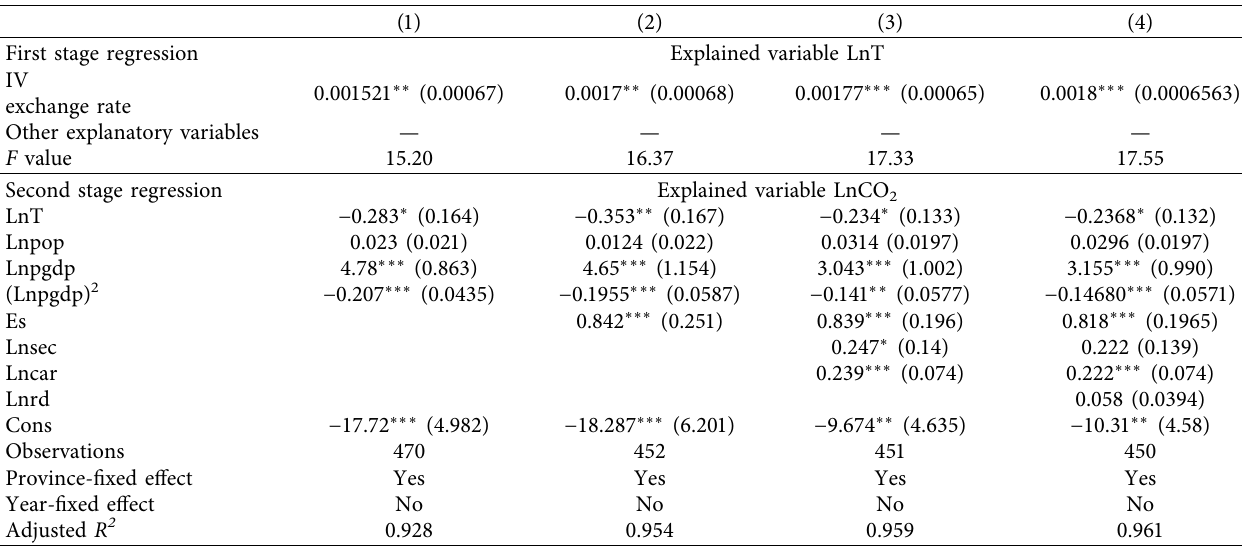
Table 3: IV estimation results.